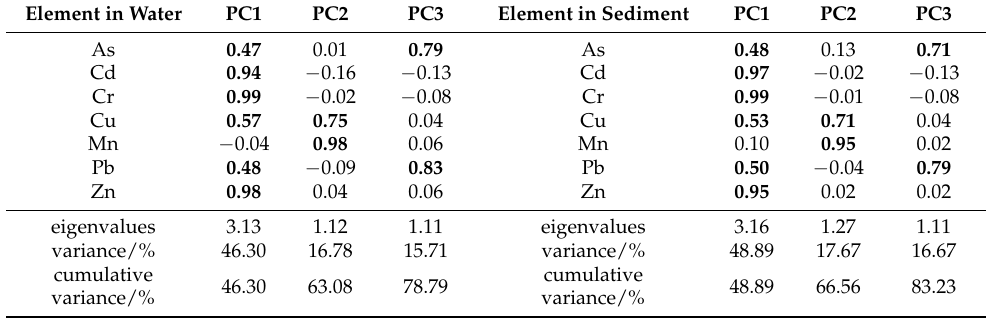
** and * indicate that the correlation is significant at the 0.01 and 0.05 level, respectively. Table 5. Principal component analysis of PTEs in water and sediment of Danshui. (The bold numbers in the table indicate they have higher factor scores). Element in Water